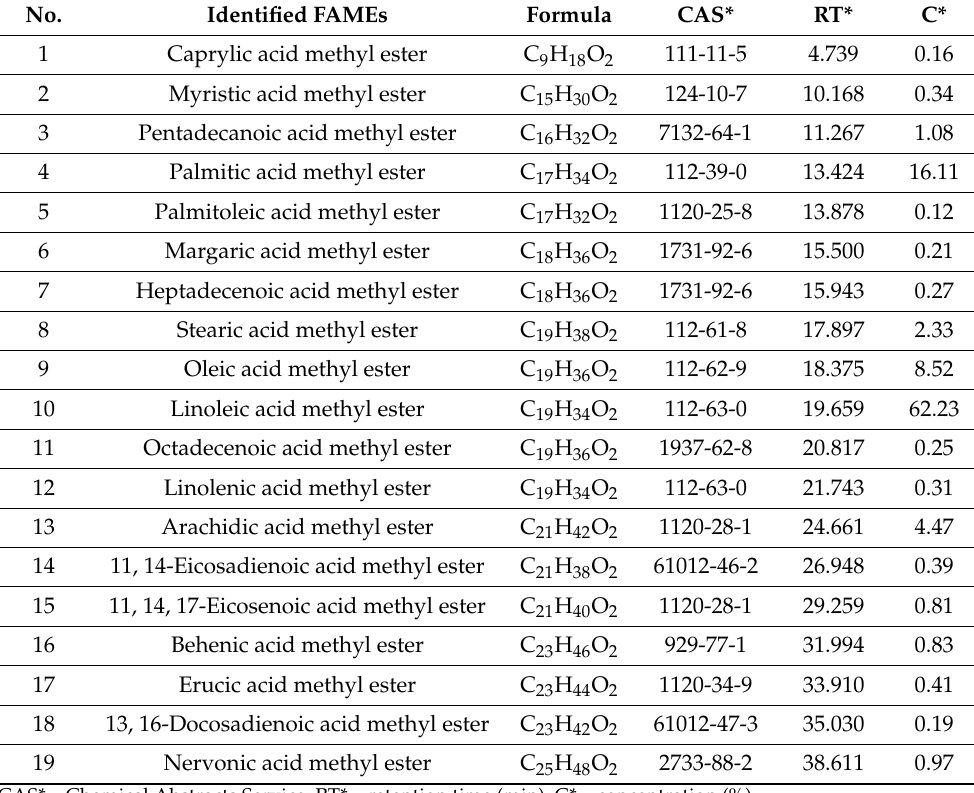
Table 2. FAME composition of Silybum marianum biodiesel determined by GC-MS.